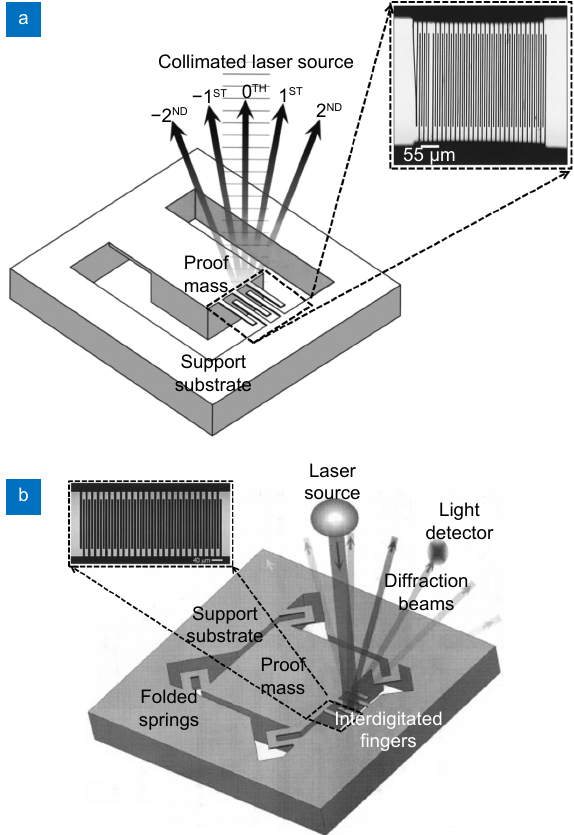
Fig. 8 | ( a ) Simplified model of a MOEMS accelerometer based on grating light valves. ( b ) Another MOEMS accelerometer based on grating light valve. Figure reproduced with permission from: (a) ref. 29 , AIP Publishing; (b) ref. 48 ,